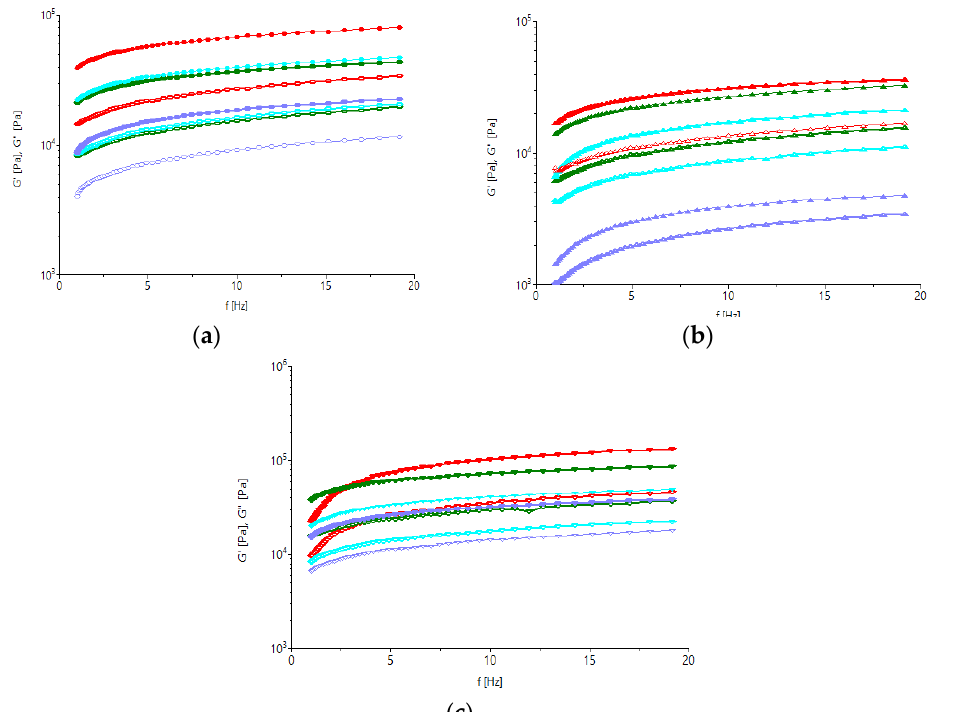
Figure 2. ( a ) G ′ G ″ dough modulus (points) and power curves (lines) depending on frequency at 550 flour dough samples for four different added oil contents: 0% (red point), 5% (green point), 10% (blue point), and 15% (purple point) ; ( b ) G ′ G ″ dough modulus (triangle with tip up) and power curves (lines) depending on frequency at 650 flour dough samples for four different added oil contents: 0% (red triangle), 5% (green triangle), 10% (blue triangle), and 15% (purple triangle); ( c ) G ′ G ″ dough modulus (triangle with tip down) and power curves (lines) depending on frequency at 1350 flour dough samples for four different added oil contents: 0% (red triangle), 5% (green triangle), 10% (blue triangle), and 15% (purple triangle).